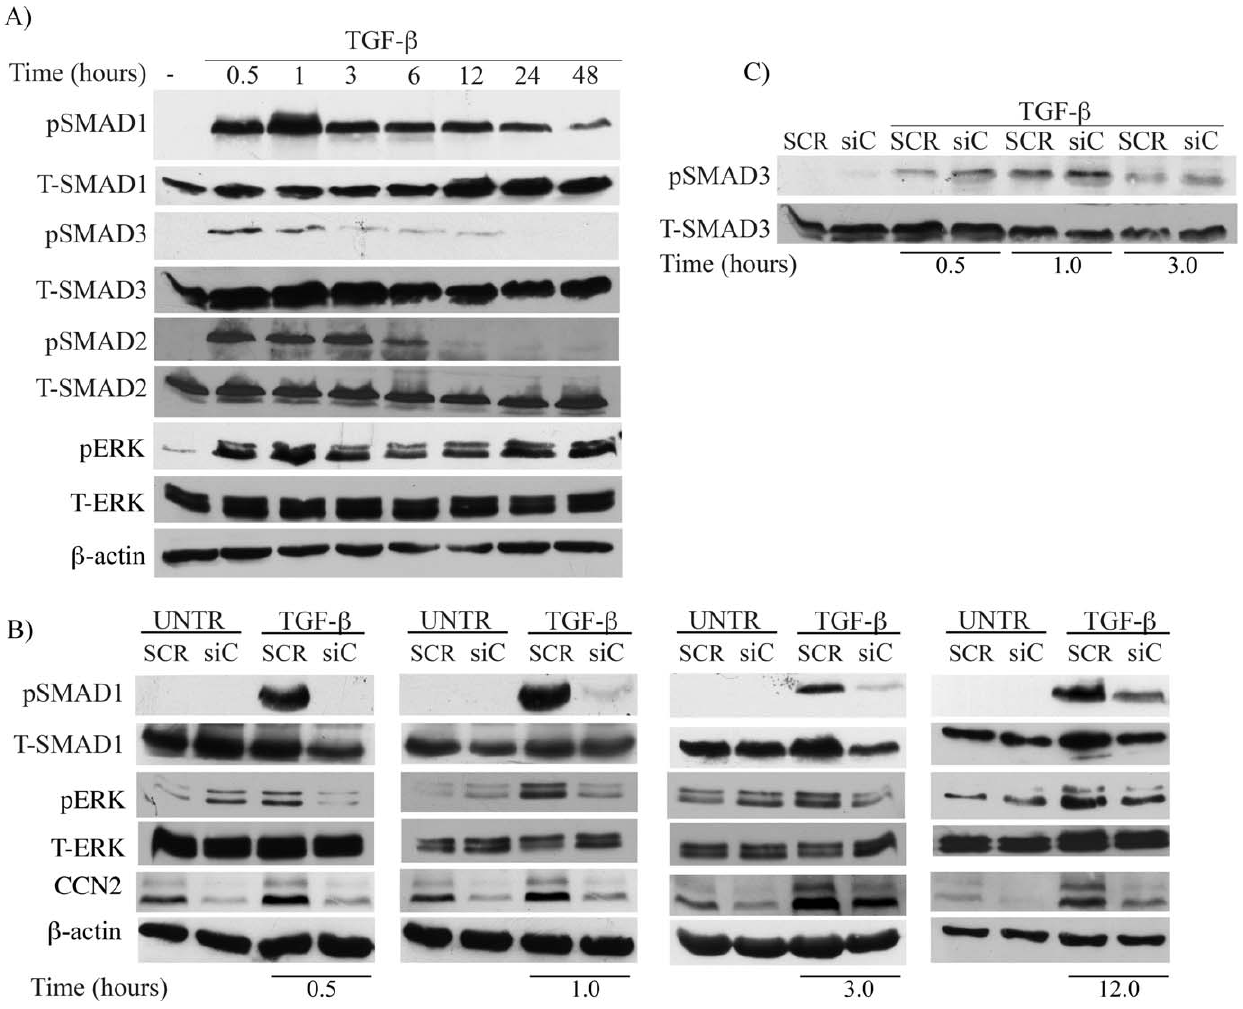
Figure 2. CCN2 is required for the TGF- b induced activation of Smad1 and Erk1/2 pathways. (A) Foreskin fibroblasts were stimulated with TGF- b for the indicated time periods and analyzed for Smad1, Smad3, Smad2 and Erk phosphorylation kinetics. (B,C) Fibroblasts were transduced with AdenoCCN2 siRNA or the control scrambled virus for 72 h followed by stimulation with TGF- b for the indicated time points. Phosphorylation status and the total protein levels of Smad1, Erk1/2, and Smad3 were determined by western